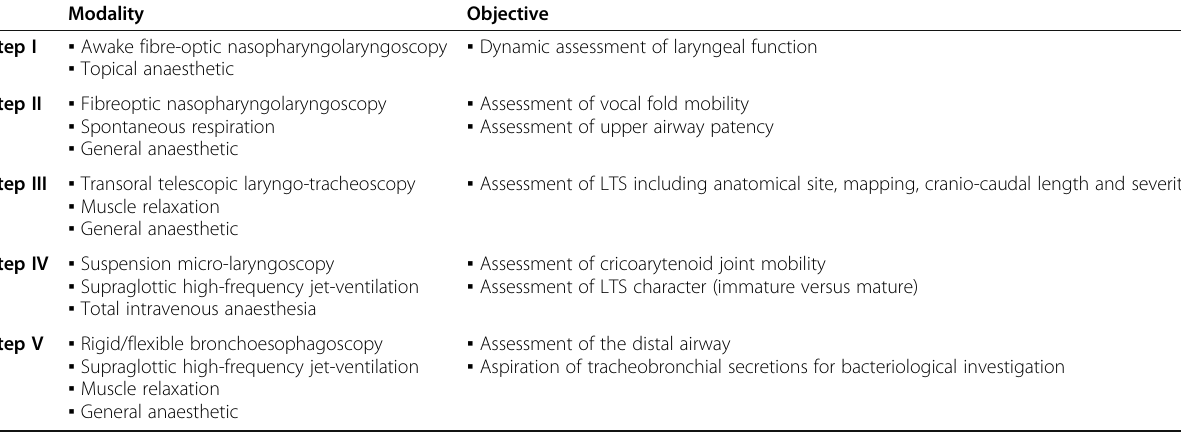
Table 2 Five-step endoscopic airway assessment in LTS [5] Modality